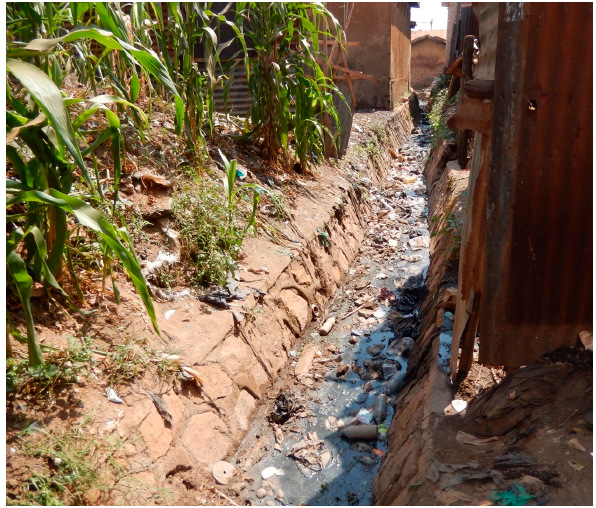
Figure 6. Drainage Ditch.